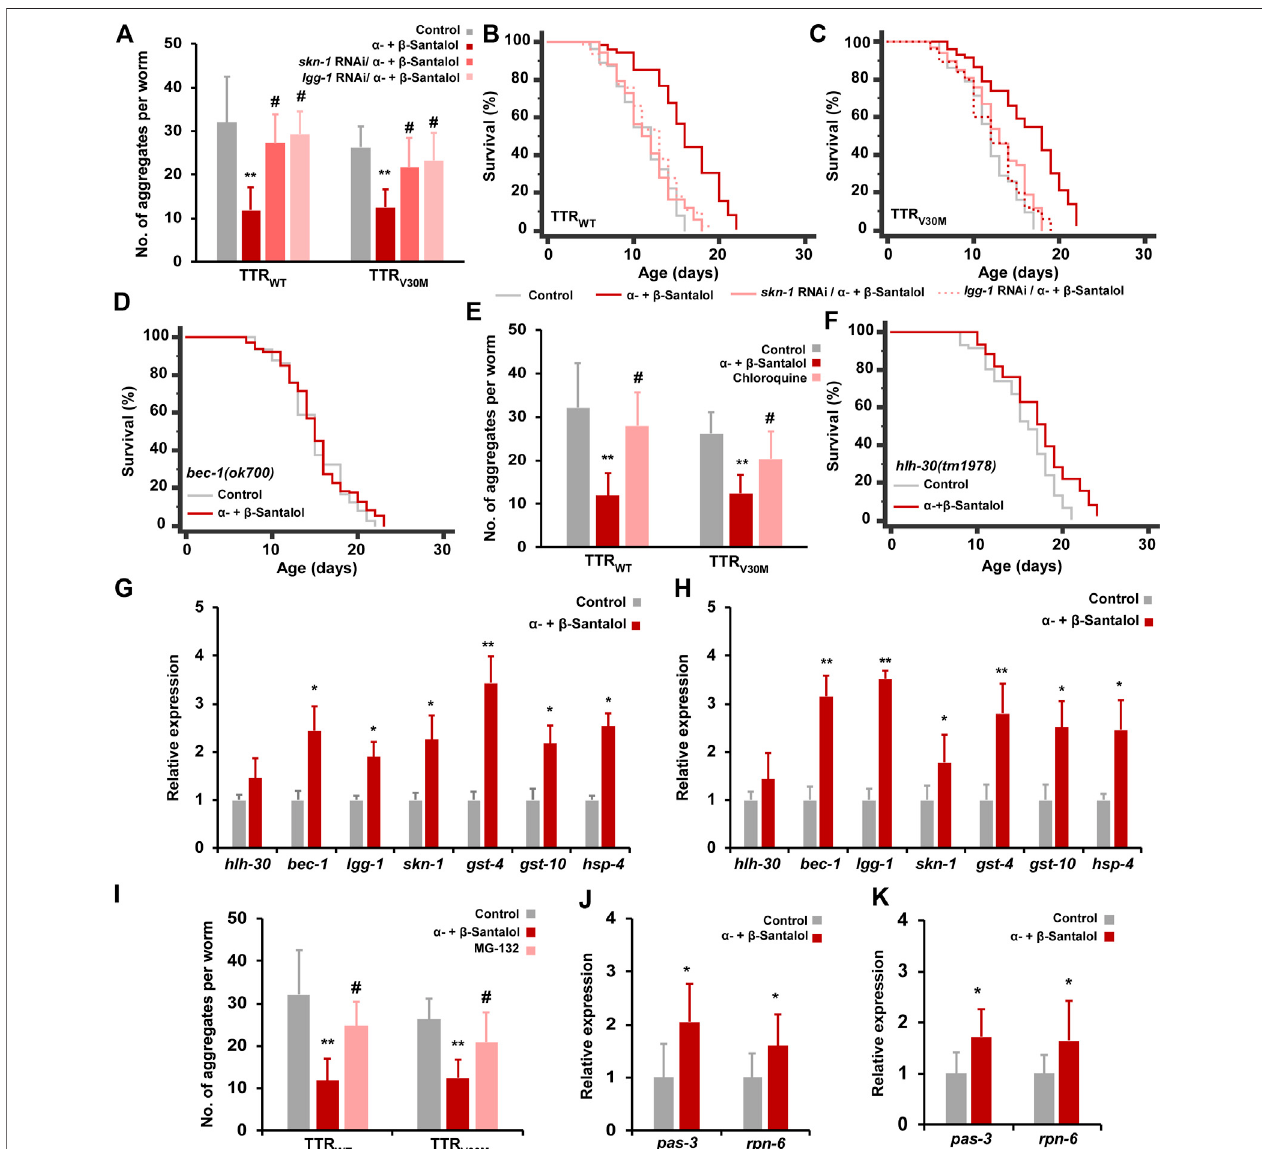
FIGURE6 | The bene fi cial synergistic effectofsantalol isomers on TTR aggregation requires SKN-1, autophagy, and proteasome. (A) Levels of TTRaggregates in worms treated with α -+ β -santalol fed-with skn-1 and lgg-1 RNAi. (B,C) Survivorship curves of TTR WT and TTR V30M worms de fi cient in skn-1 and lgg-1 (RNAi). (D) Survivorship curves of bec-1 mutants raised at 20 ° C on plates containing santalol isomers. (E) The blocking effect of chloroquine on TTR WT and TTR V30M aggregates in worms treated with santalol isomers. (F) Survivorship curves of hlh-30 loss-of-function worms treated with santalol isomers. (G,H) Relative expression rate of autophagyand SKN-1 target genesinTTR WT and TTR V30M worms. (I) Theblocking effect ofMG-132onTTR WT andTTR V30M aggregates inworms treatedwithsantalol isomers. (J,K) Relative expression rateofproteasome subunits inTTR WT and TTR V30M worms. Dataarepresented asmean ±SD; * p < 0.05, ** p < 0.01vs. control; # p < 0.01 vs. α -+ β -santalol. See Supplementary Table S5 for statistical details of lifespan